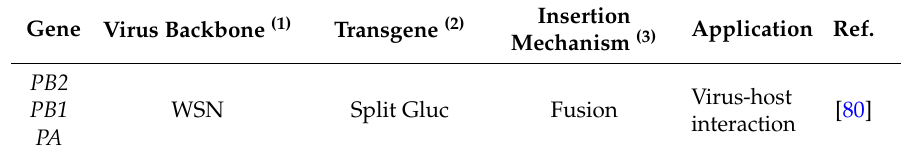
Table 3. Recombinant influenza A viruses expressing reporter gene in the viral PB1